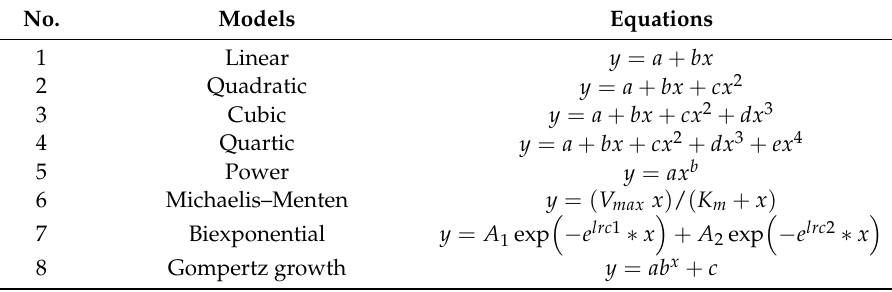
Table 1. Parametric